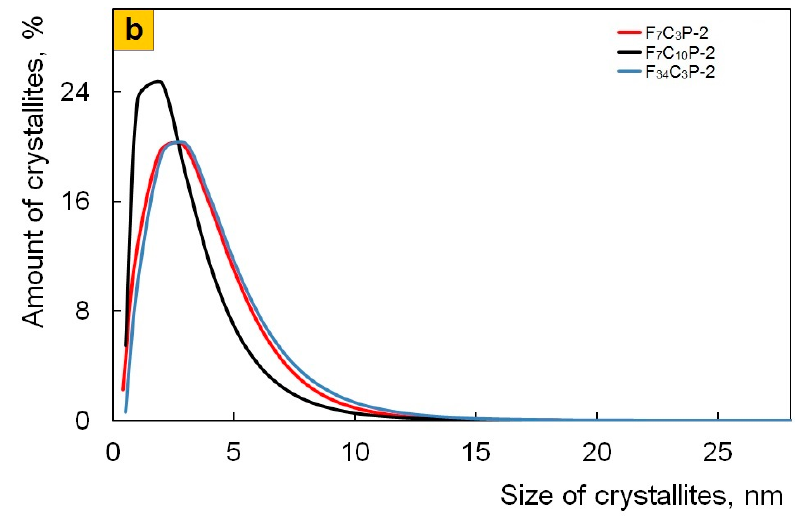
Figure 8. Fe 3 O 4 crystallites size distribution in Fe 3 O 4 /SWCNT and Fe 3 O 4 /SWCNT/PDPAC, prepared in alkaline ( a ) and acidic media ( b ).